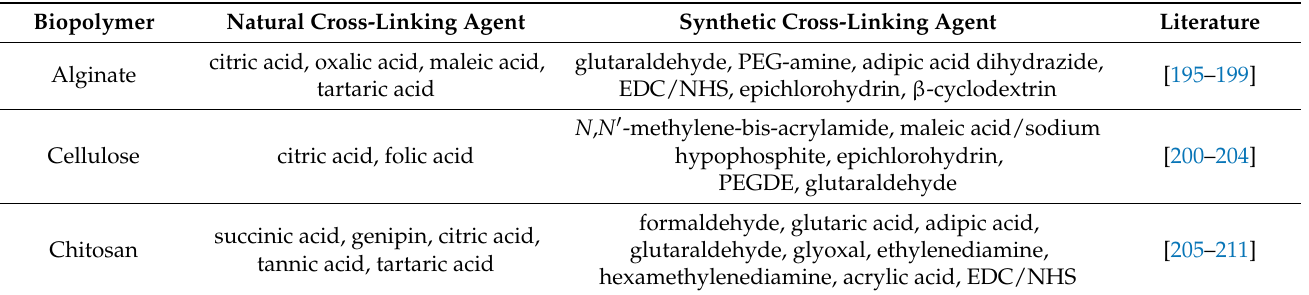
Table 3. Natural and synthetic cross-linking agents used in the case of selected biopolymers cross- linked